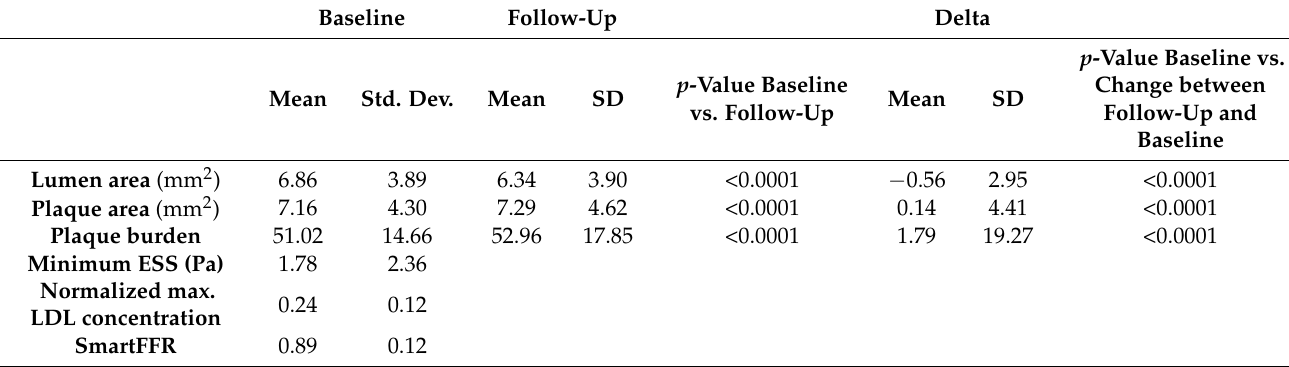
Table 2. CCTA imaging variables at baseline and follow-up and results of computational modeling of endothelial shear stress (ESS), LDL concentration and calculation of SmartFFR at baseline.